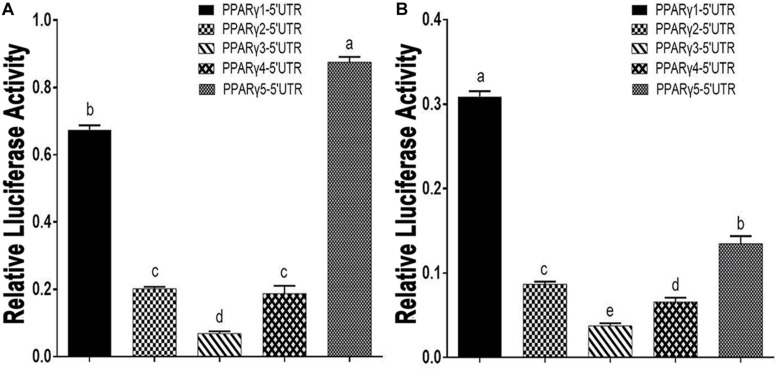
Effects of PPARγ 5′ UTR isoforms on reporter gene activity. (A) The luciferase activity of each of the PPARγ 5′ UTR reporter constructs was measured in DF1 cells. (B) The luciferase activity of each of the PPARγ 5′ UTR reporter constructs was measured in ICP1 cells. Data are expressed as mean ± SEM (n ≥ 3 independent experiments). Lower case letters above bars indicate the order of expression levels, “a” represents the highest expression level, “e” represents the lowest expression level. Bars with different superscripts are mutually statistically different. ANOVA followed by Tukey’s multiple comparison test was used to determine significance.